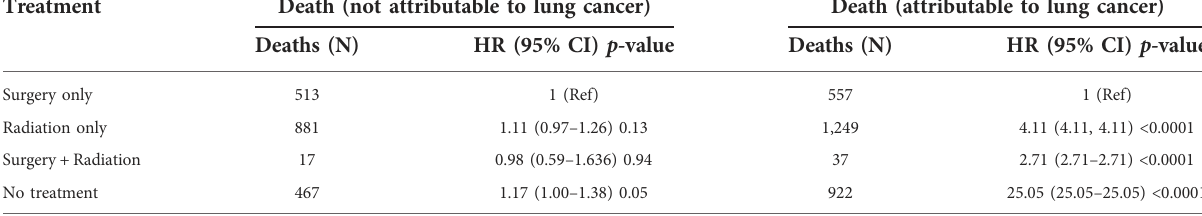
TABLE 5 Treatment and cause-speci fi c mortality in the advanced age early stage non-small cell lung cancer cohort.